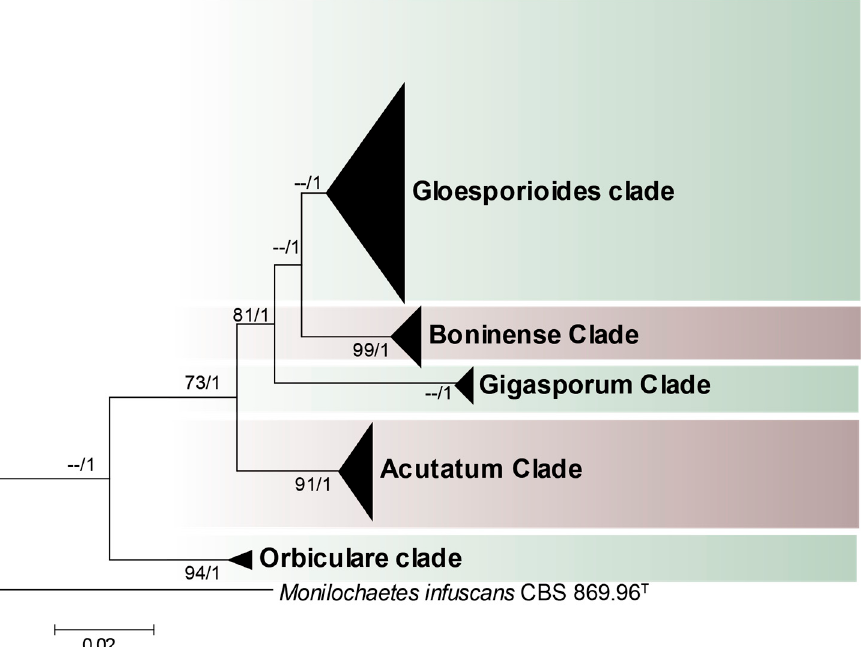
Figure 1. An ML tree of the Colletotrichum clades reported in northern South America (Colombia, Ecuador, Peru, and Venezuela). The tree was created based on the alignment of ITS sequences (465 bp) retrieved from GenBank. Branch lengths are proportional to phylogenetic distance. The best substitution model for ML was determined to be T92+G. Bootstrap support values/Bayesian posterior probability scores above 70%/0.95 are indicated on the nodes. The tree was rooted to Monilochaetes infuscans CBS 869.96 (type strain).